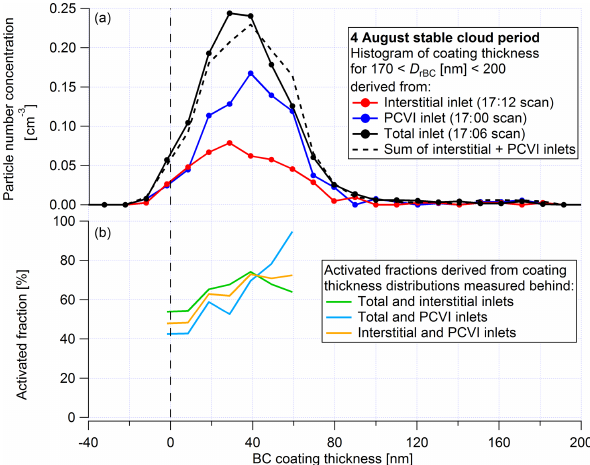
Figure 10. (a) Histograms of coating thickness for BC cores with rBC core mass equivalent diameter between 170 and 200nm as inferred from the SP2 data for the 4 August stable cloud period. (b) Activated fractions derived from the histograms shown in panel (a) and shown for the range of coating thicknesses between 0 and 60nm, for which counting statistics are sufficient. The three calcu- lations of activated fractions are redundant (based on data behind three inlets); this explains why the orange line is an average of the light blue and the green lines. Note that unphysical negative coat- ing thickness values are caused by random noise for BC-containing particles with no or very little